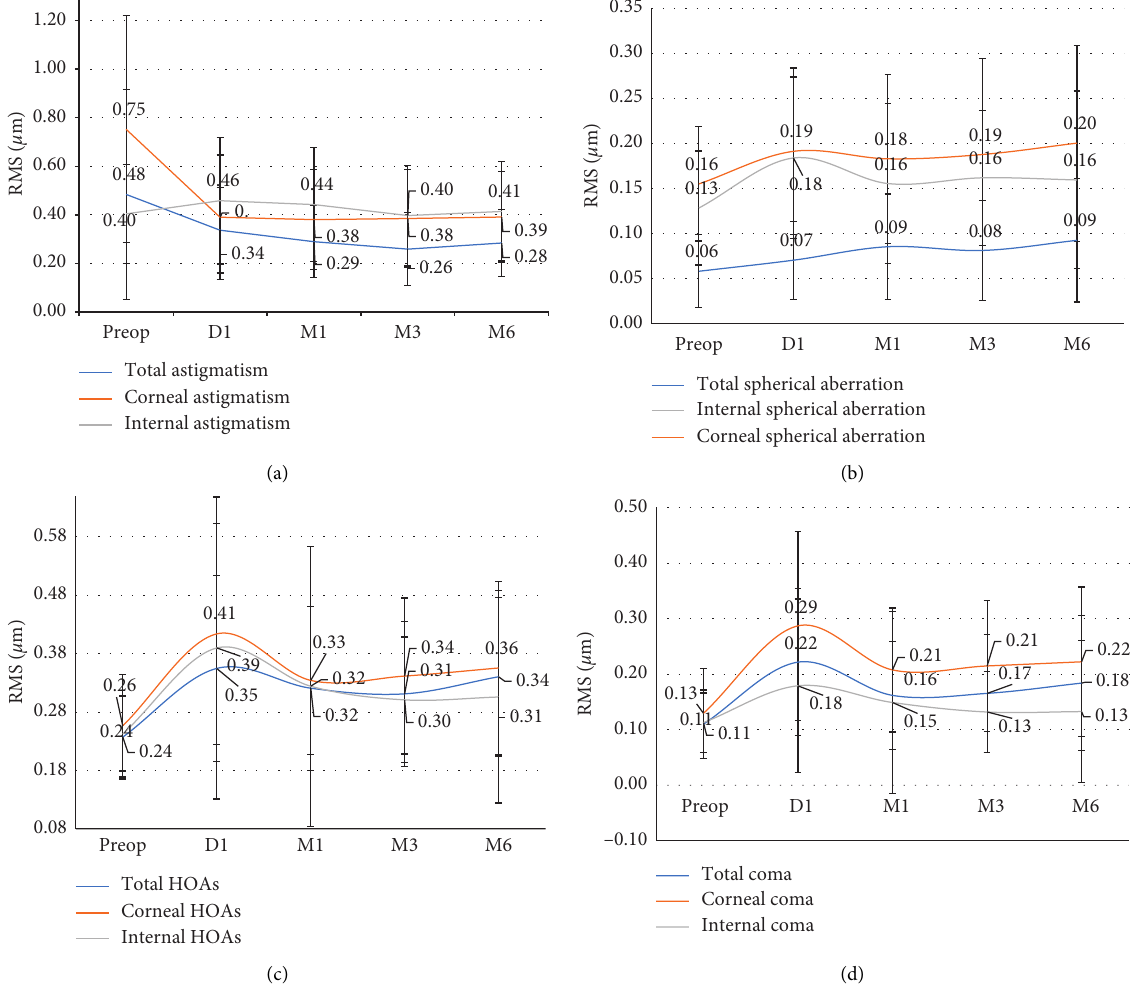
Figure 8: Evolution of RMS ocular total, corneal, and internal aberrations ( µ m): astigmatism evolution (a), spherical aberration evolution (Zernike SA4 +SA12) (b), high-order aberrations (HOAs: 3rd order and higher) (c), and coma evolution (d).